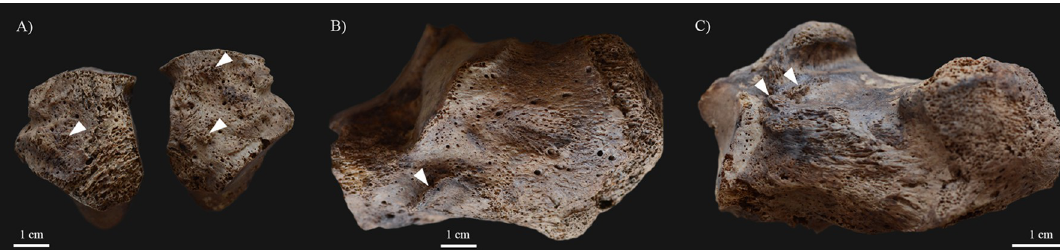
Fig 6. Bony changes indicative of motor peripheral neuropathy in the feet of KK61. A) Exostoses on the dorsal surface of the left and right cuboid bones (white arrows); B) Bony ridges on the lateral surface of the left calcaneus (white arrow); and C) Exostoses on the medial surface of the right calcaneus (white